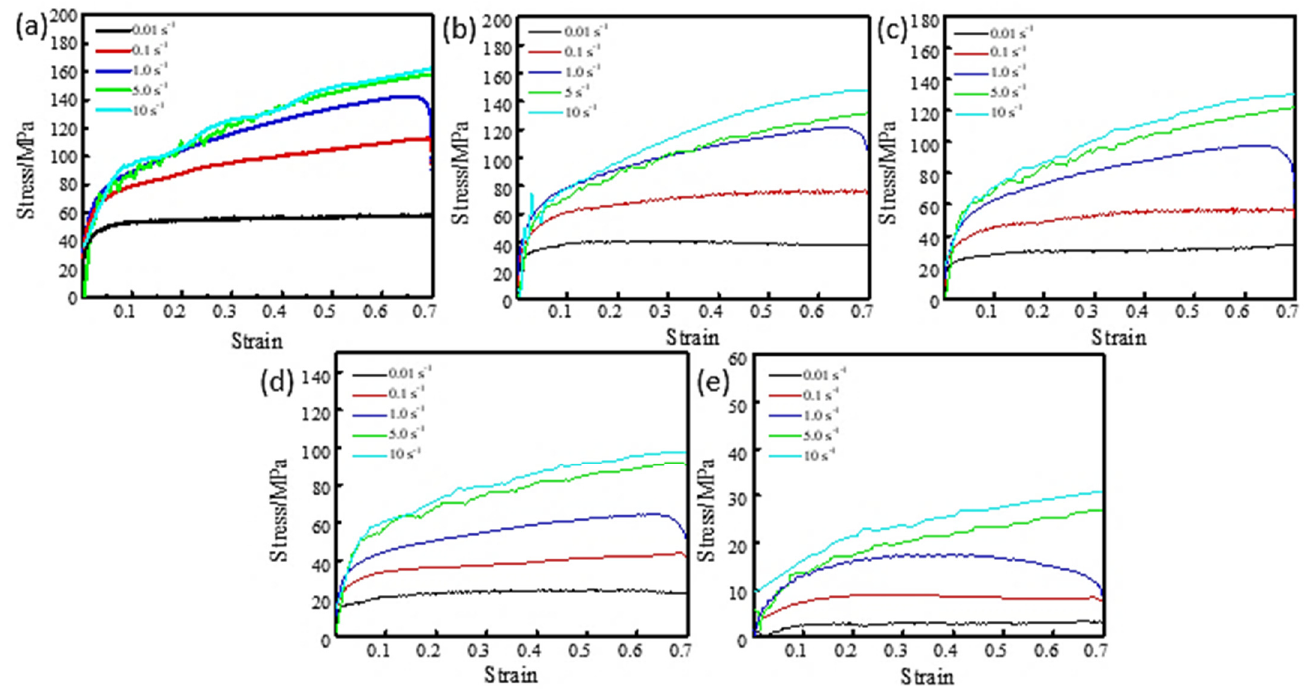
Figure 2. The curves of true stress and true strain at different temperatures: ( a ) 700 °C; ( b ) 750 °C; ( c ) 800 °C; ( d ) 850 °C; ( e ) 900 °C.